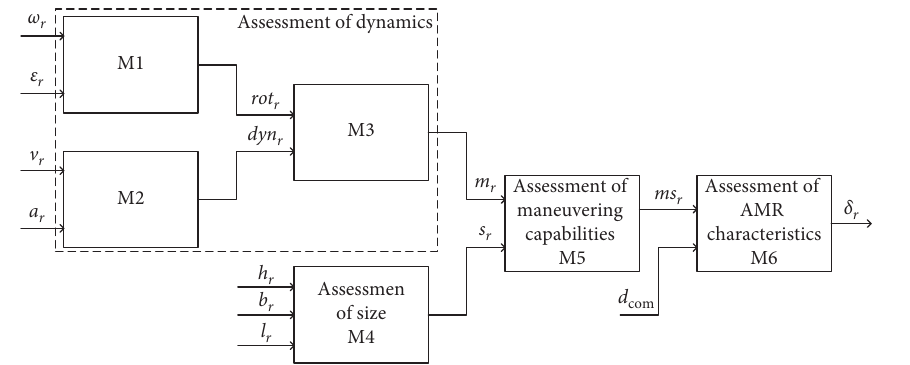
Figure 15: Structure of the model of assessment of the AMR’s characteristics.